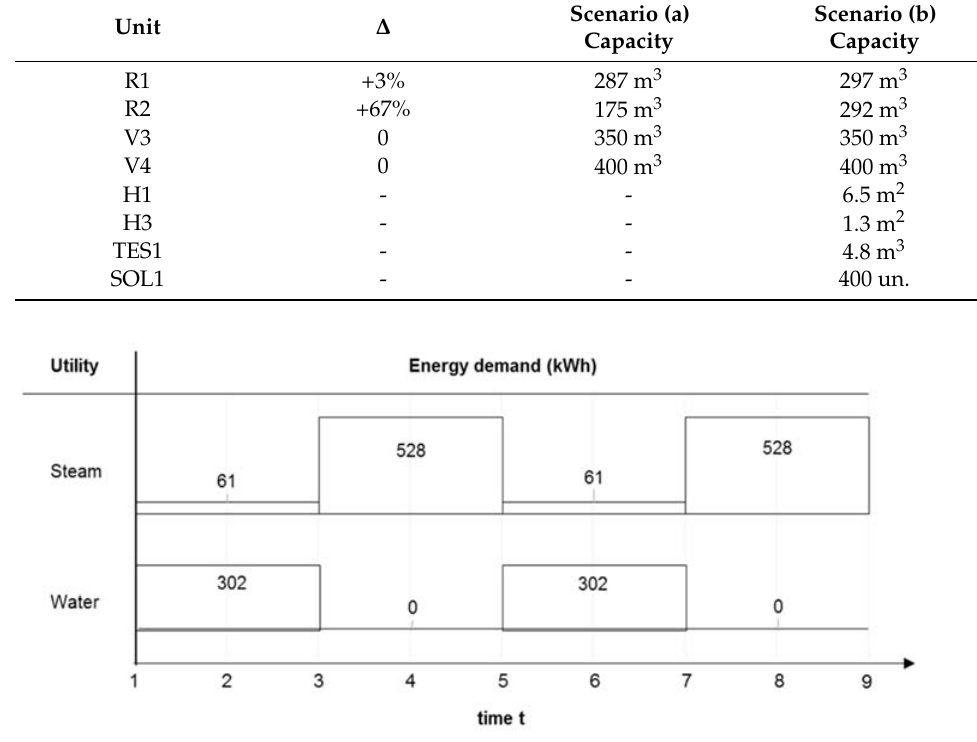
Figure 5. Energy profile for scenario (a).